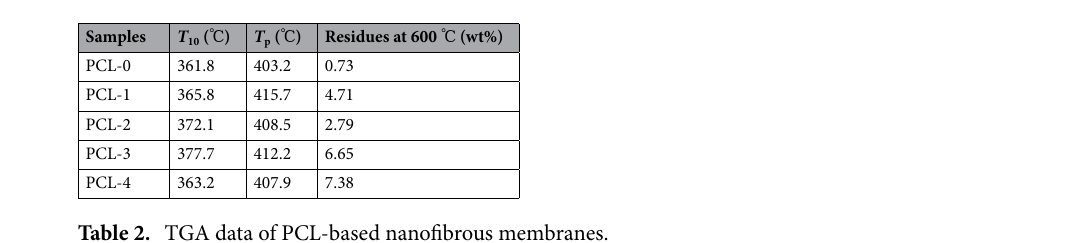
Table 2. TGA data of PCL-based nanofibrous